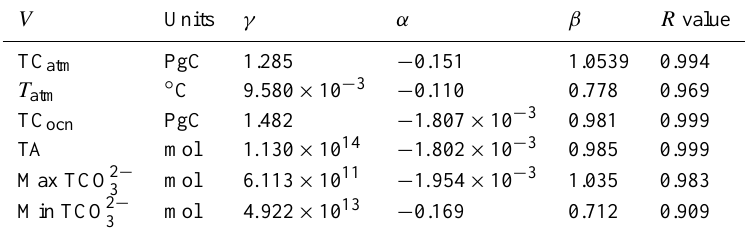
Table 7. Power law scalings for Paleocene–Eocene configuration, global variables, and (cid:49)V = γD α E β . D in yr and E in